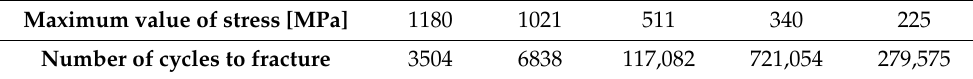
Table 8. Stress and number of cycles from the fatigue test of the Hardox 450 welded in MAG.